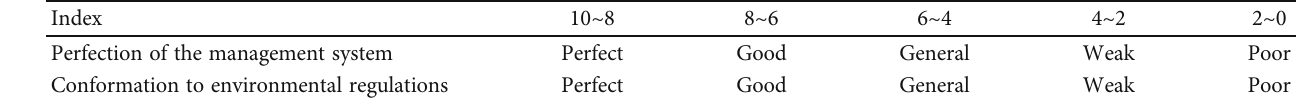
Table 3: Scoring criteria.